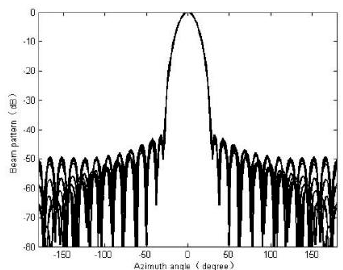
Figure 7. Broadband focused beam pattern with an optimized algorithm.